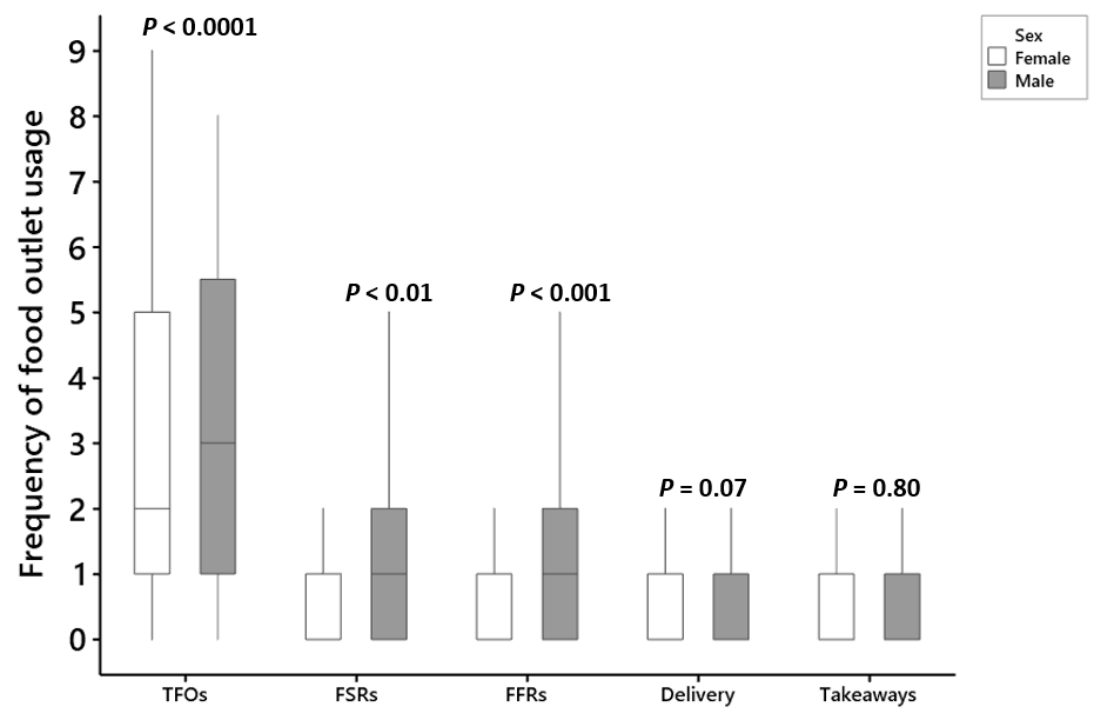
Figure 2. Comparison between the usage of different types of food outlets among males and females, FSRs = full-service restaurants, FFRs = fast-food restaurants, TFOs = total food outlets.